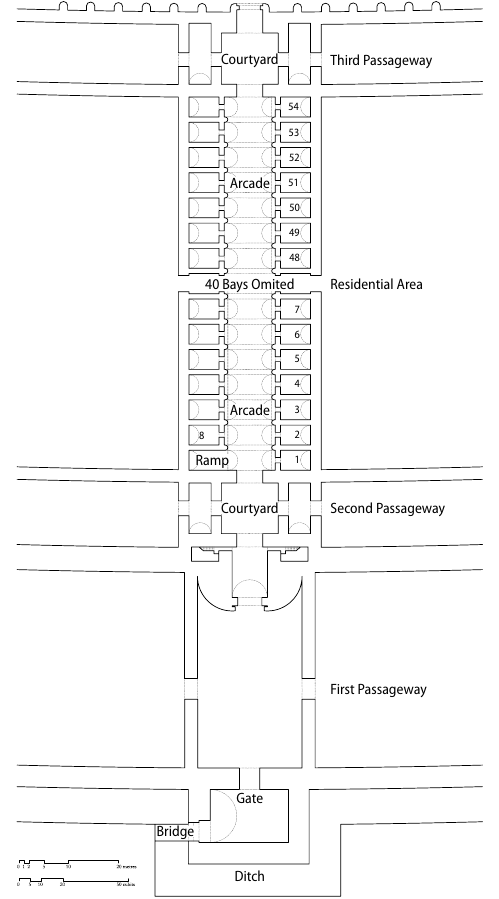
fig. 8. Hypothetical Plan of the Main road, the City of Peace. Source : reproduced by the author after